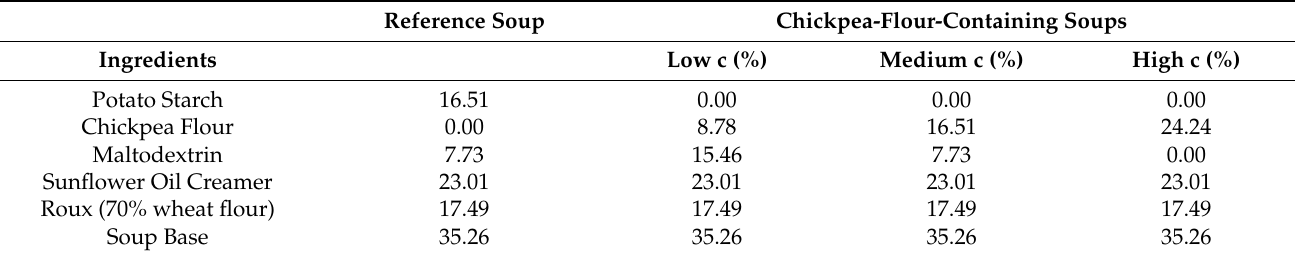
Table 1. Instant soup recipes for low, middle, and high concentrations of potato starch or chickpea flour. Reference